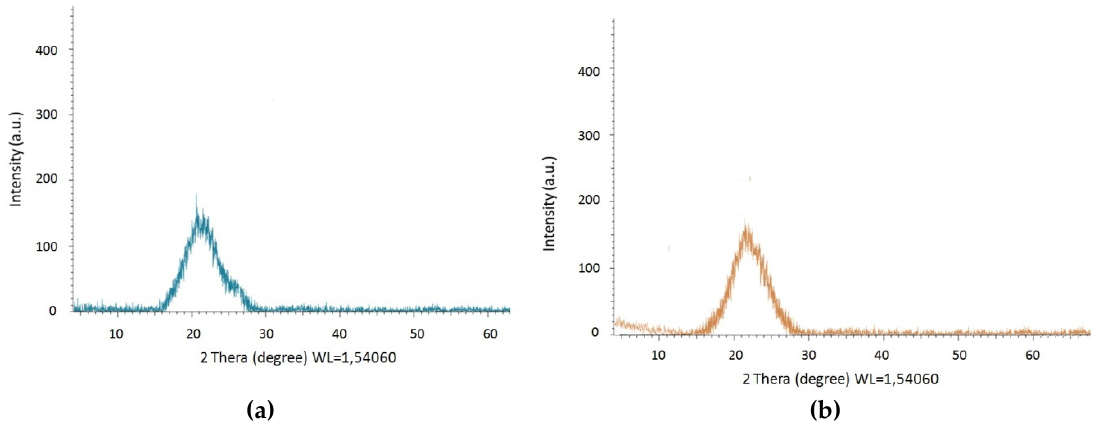
Figure 6. Powder X-ray diffraction XRD (PXRD) of the [I-Cu] n ( a ) and [II-Cu] n ( b ) .